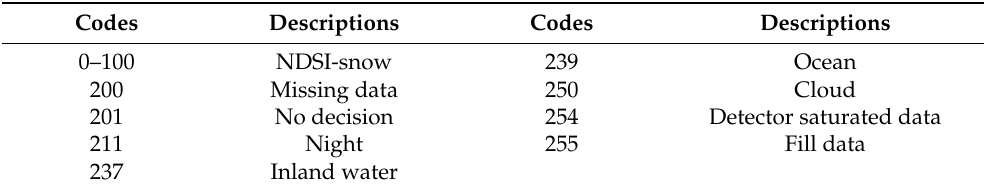
Table 1. Definition of attributes of NDSI_Snow_Cover in MOD10A1 C6.